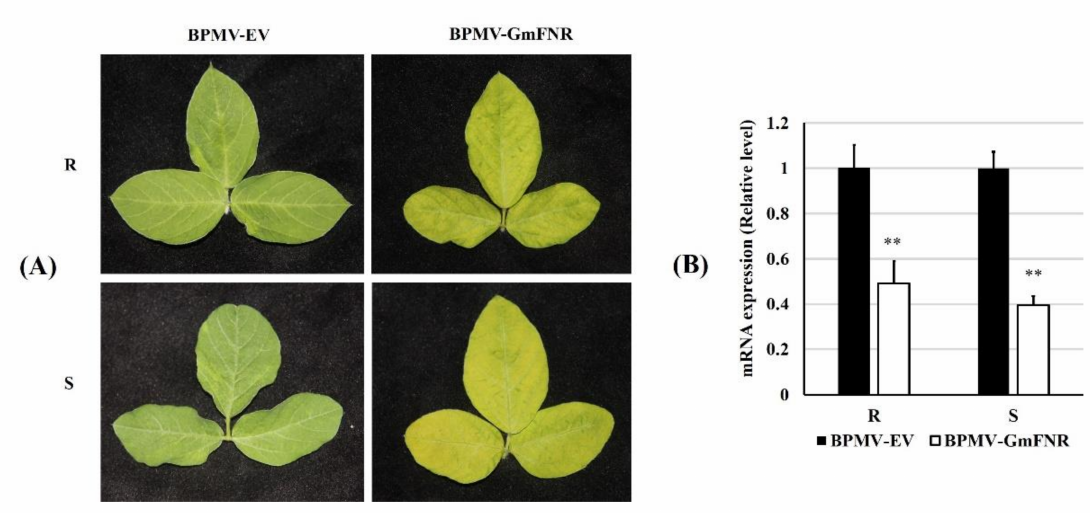
Figure 2. Silencing of GmFNR in resistant (R) and susceptible (S) lines. ( A ) Symptoms of BPMV in R and S lines, ( B ) Relative expression of control (BPMV-EV) and silencing (BPMV-GmFNR) plants in R and S lines. “**” indicates the statistical significance at p < 0.01, t-